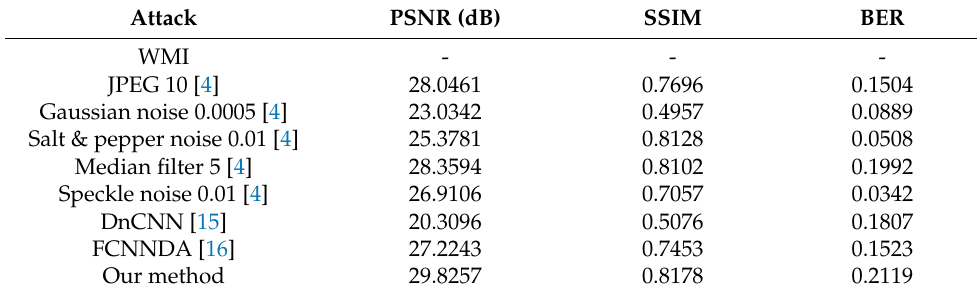
Table 2. Comparison of evaluation indicators; watermark size of 32 × 32.